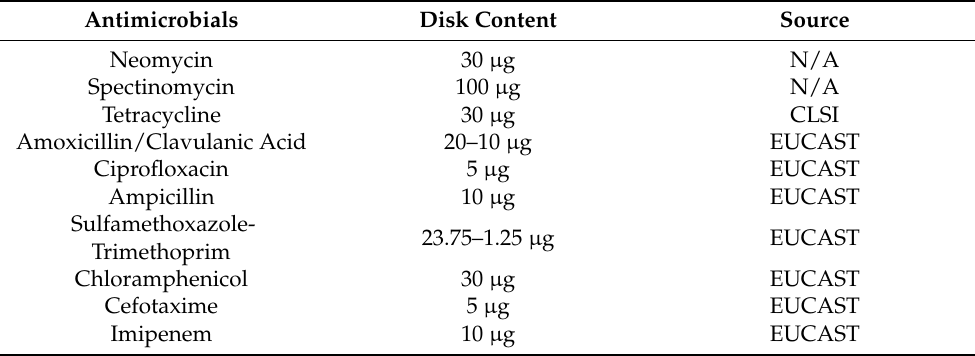
Table 8. Disk contents used to determine antimicrobial susceptibility of E. coli isolates and source of clinical